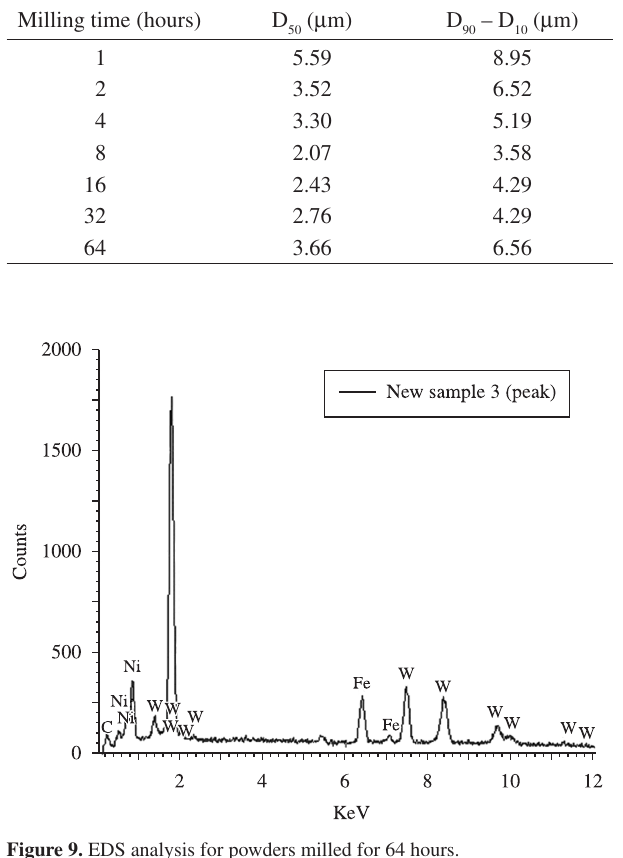
Figure 7. EDS analysis for powders milled for 16 hours.